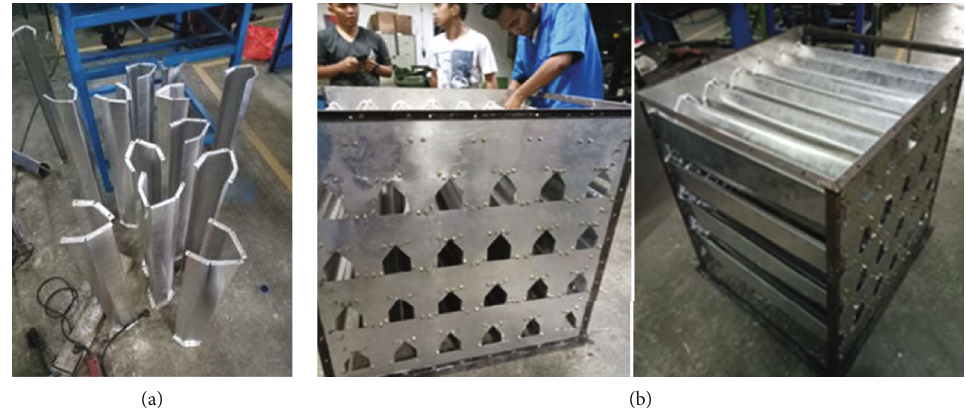
Figure 4: (a) Photograph of the air duct. (b) Photograph of the drying section.